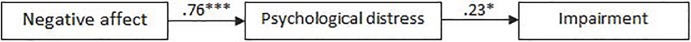
Empirically supported model of disruption to TCS related activities during the week before completing a shift on the crisis line.